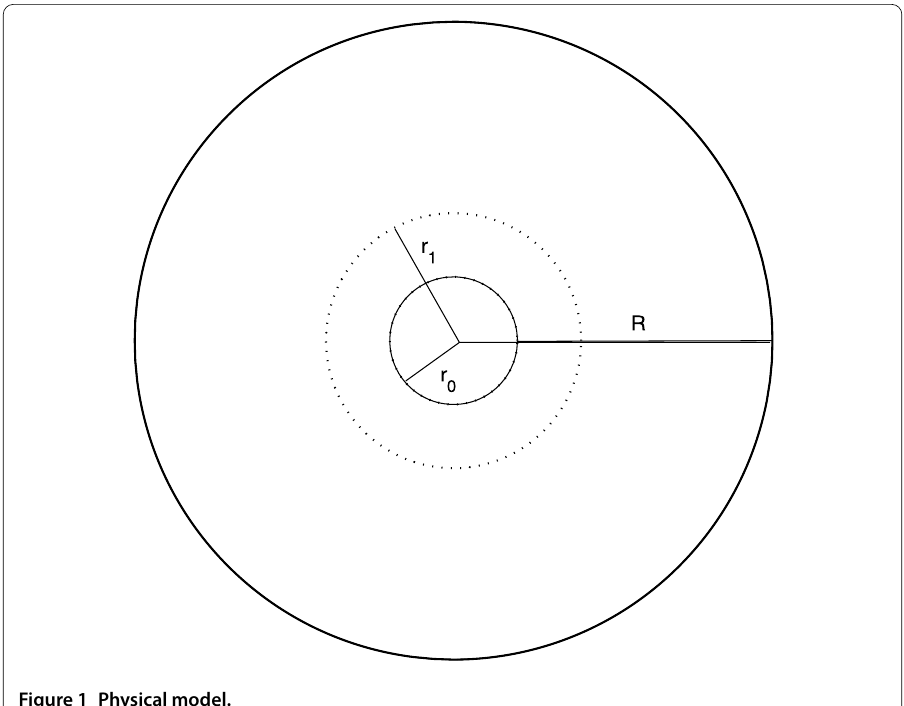
Figure 1 Physical